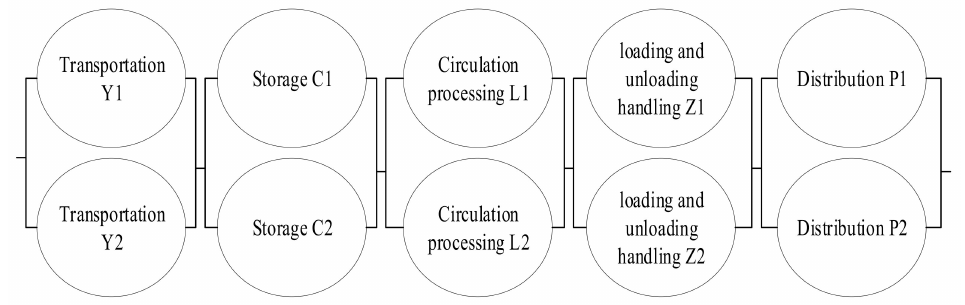
Figure 5. Structural diagram of a typical parallel series logistics